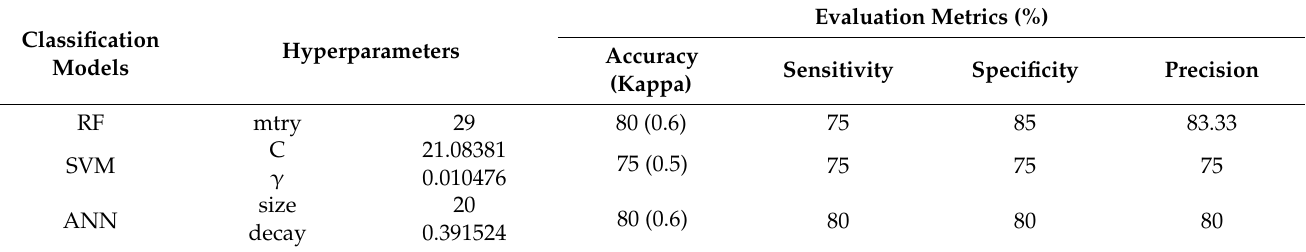
Table 3. Hyperparameters and performance of the best classification models using three ML algorithms.